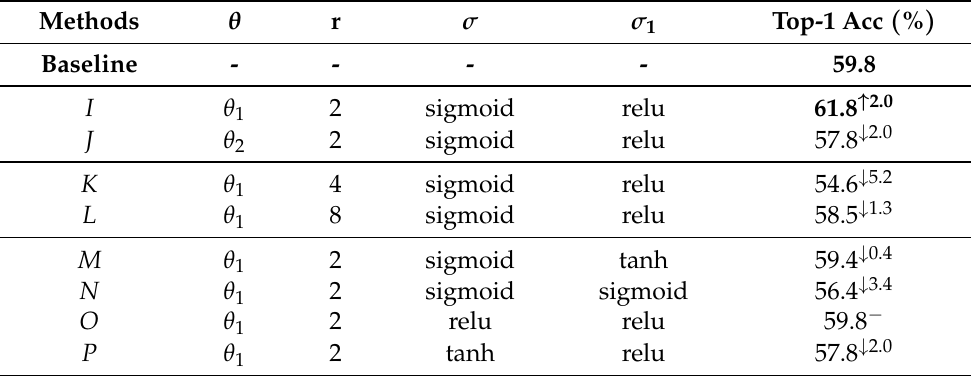
Table 3. Comparison of Top-1 Acc with different parameter settings of θ , r, σ , σ 1 . Methods